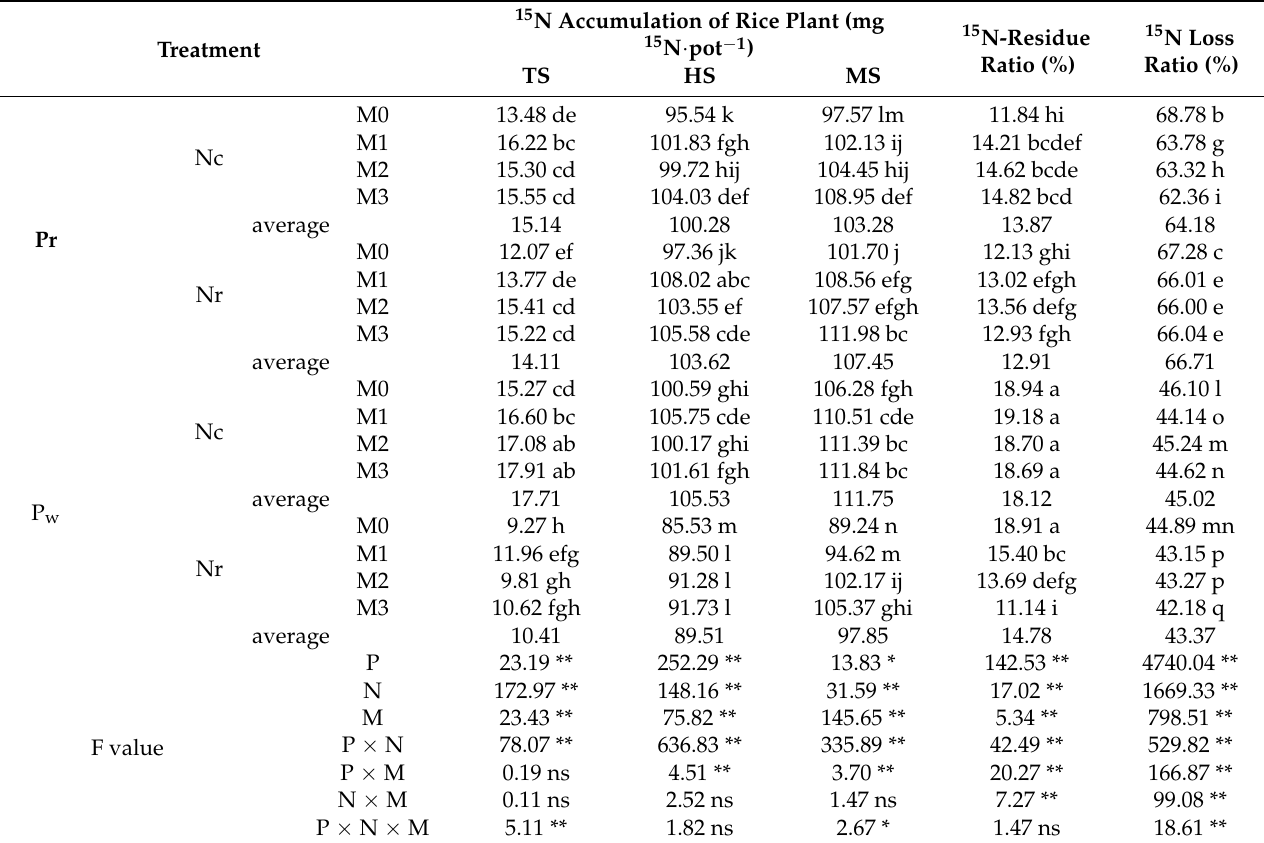
Table 6. Fate of residual nitrogen in previous crops in rice season under rapeseed–wheat–rice rotation system.